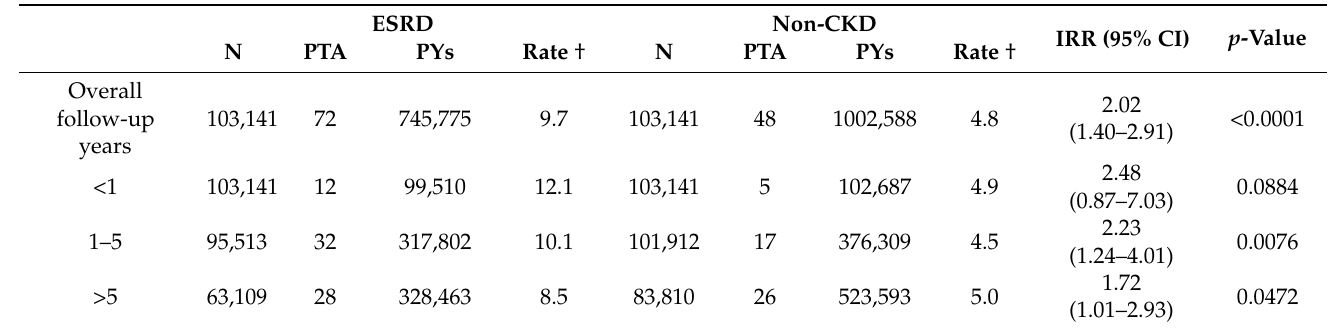
Table 2. PTA incidence.